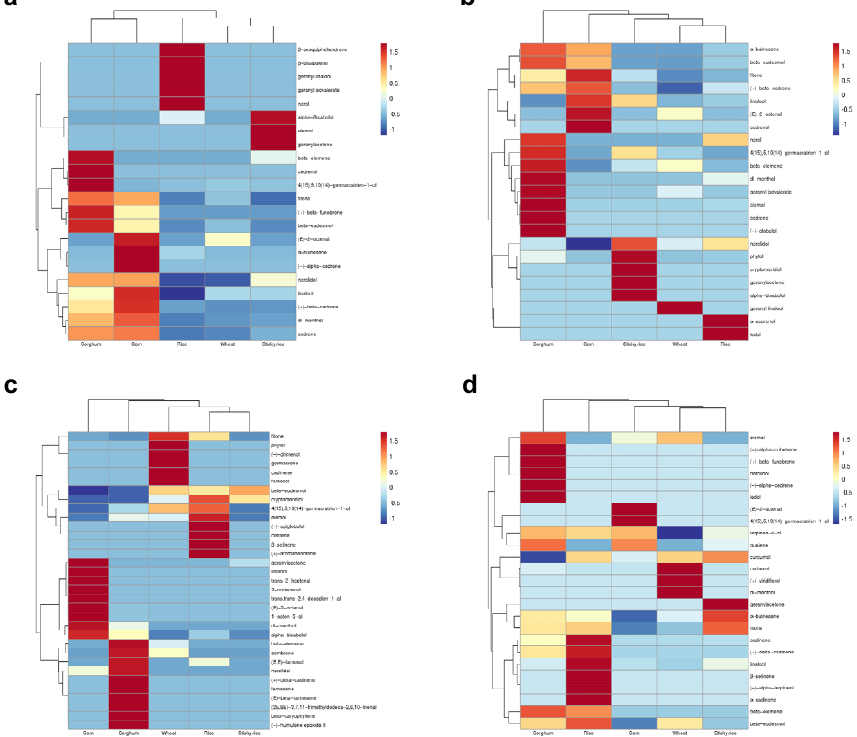
Figure 6. Heat map of terpene content in solid-state fermentation of SPS1, SPQ1, SPH1, SPG1 at 28 days. ( a ) Heat map of terpene content in solid-state fermentation of SPS1 at 28 days; ( b ) Heat map of terpene content in solid-state fermentation of SPQ1 at 28 days; ( c ) Heat map of terpene content in solid-state fermentation of SPG1 at 28 days; ( d ) Heat map of terpene content in solid-state fermentation of SPH1 at 28 days.